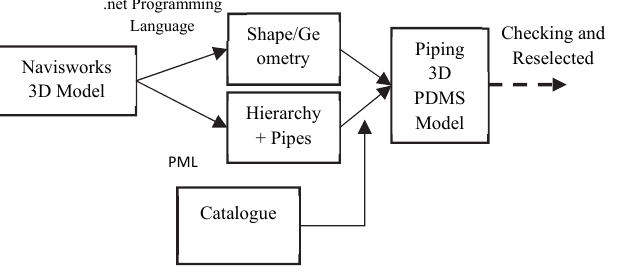
Fig. 6. Simple Flowchart of Piping Navisworks(R) 3D model